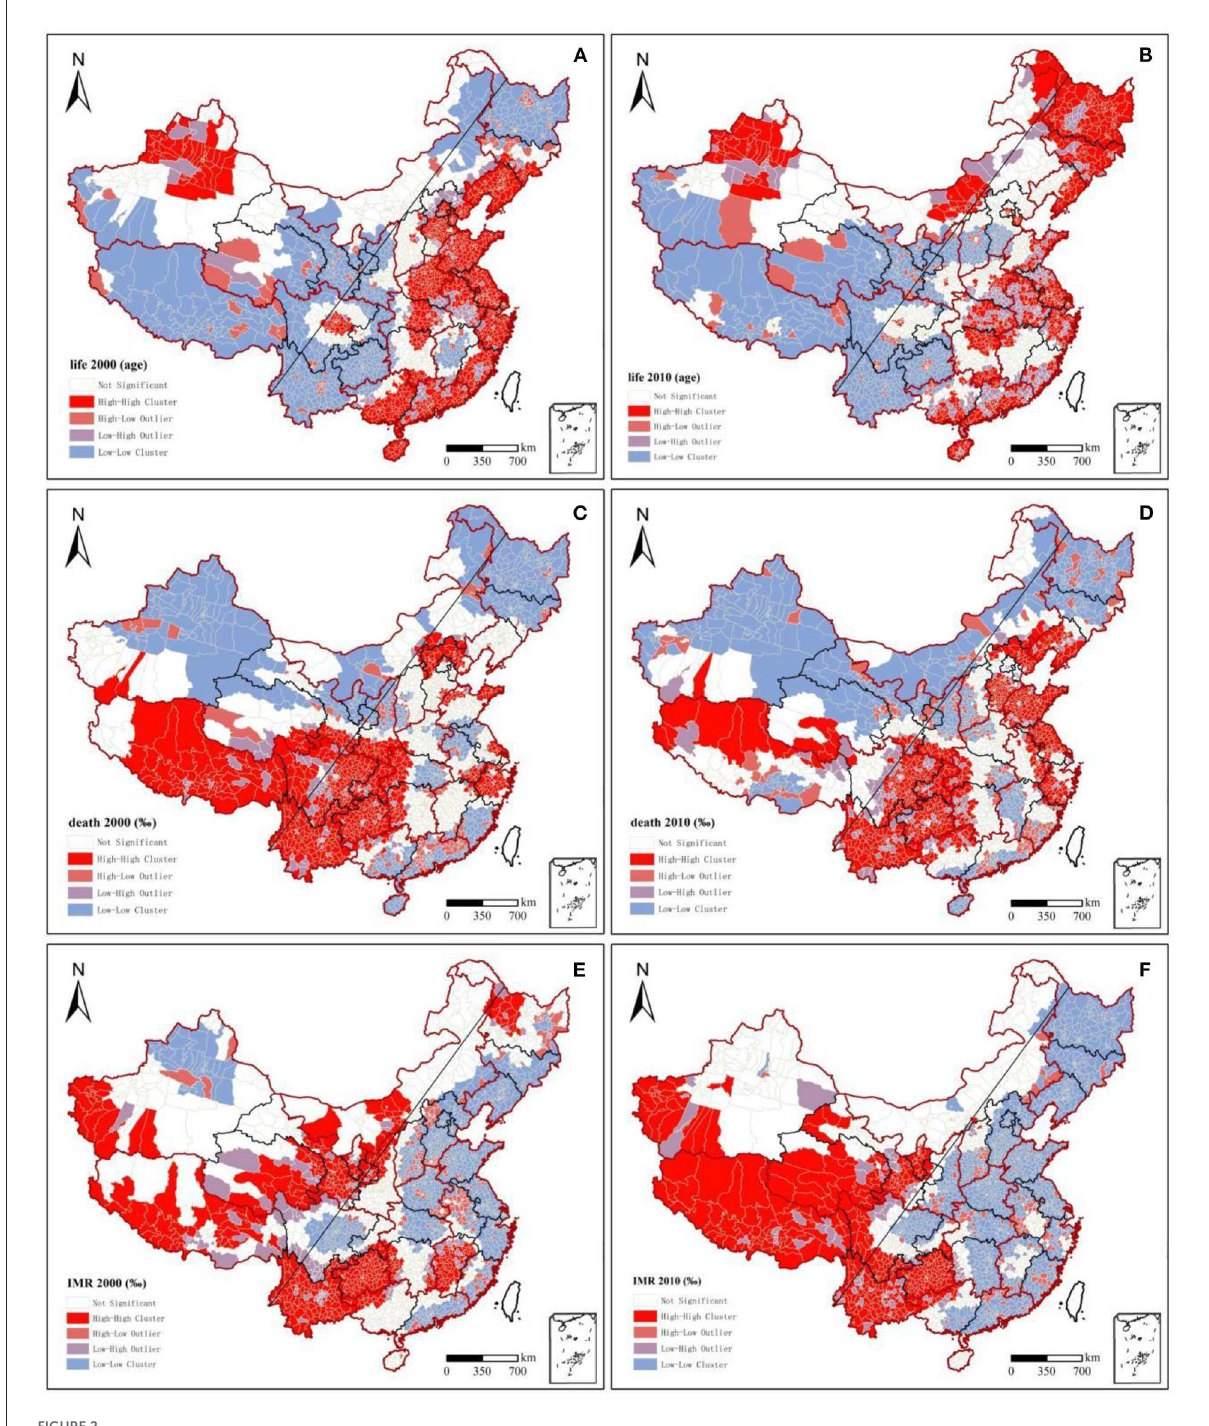
FIGURE2 Lisa clustering charts of population health, 2000–2010.